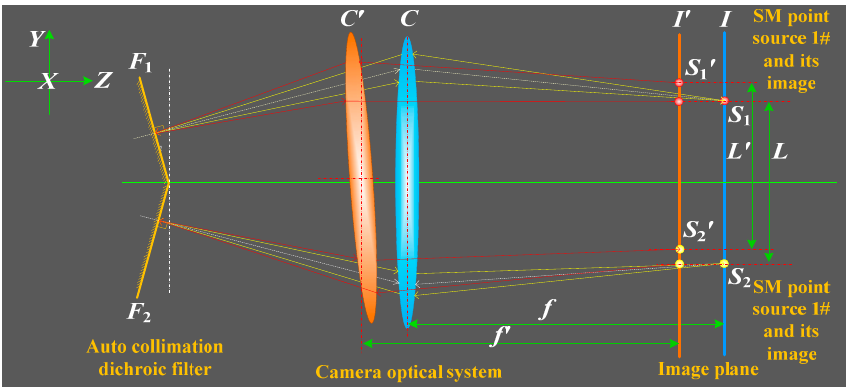
Figure 7. Imaging relationship of actual optical system.